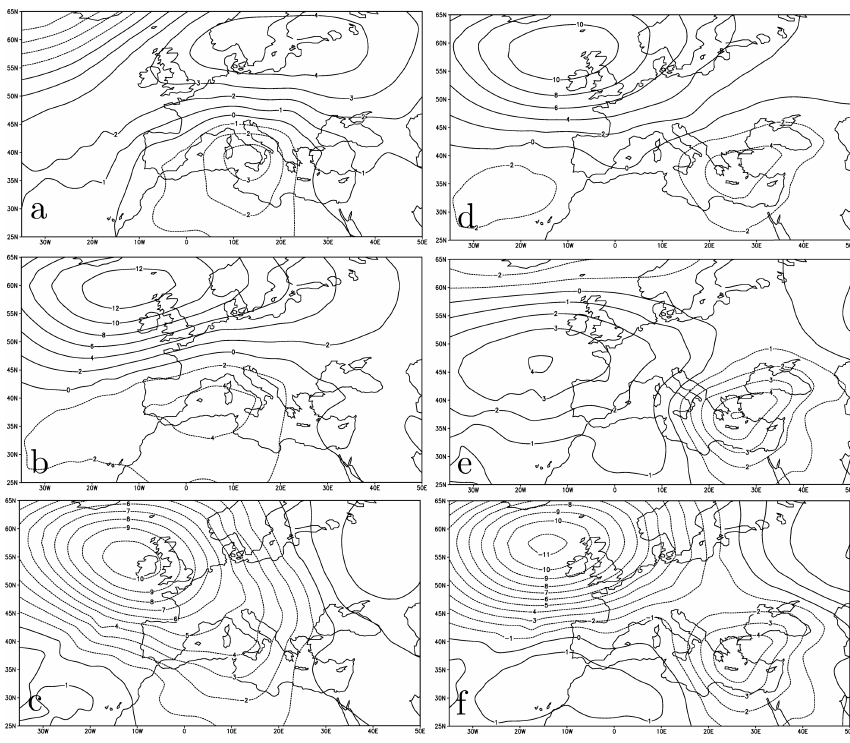
Fig. 4. As Fig. 3 but for